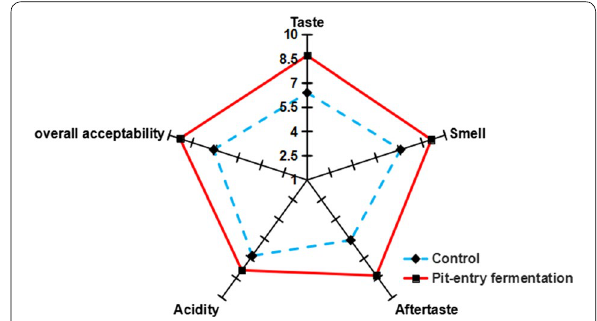
Fig. 8 The sensory profiles of the raw liquors obtained from the fermented Zaopei of the experimental and control